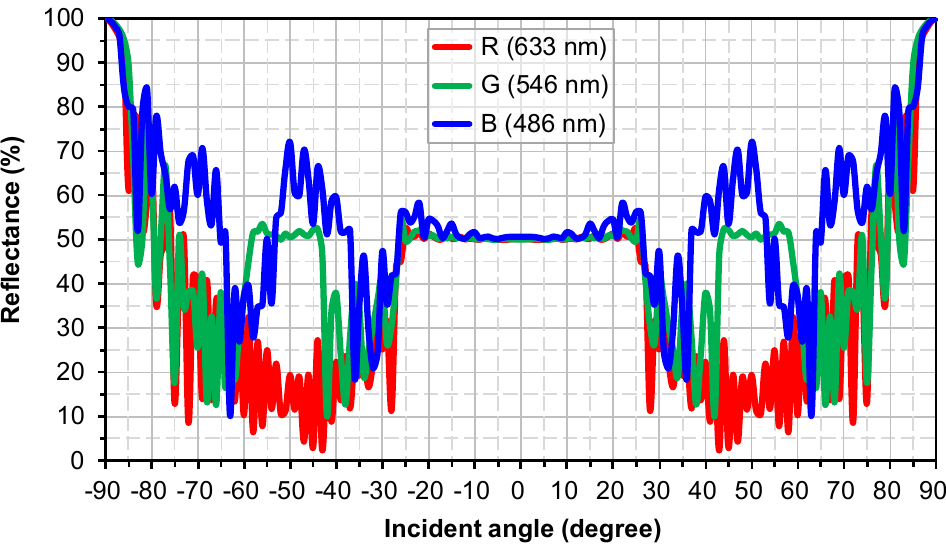
Figure 7. Reflectance with respect to the incident angle. The angular bandwidth of reflectance from 45% to 50% for R/G/B is 50/52/52 degrees, which is wide enough to cover half of the FOV.